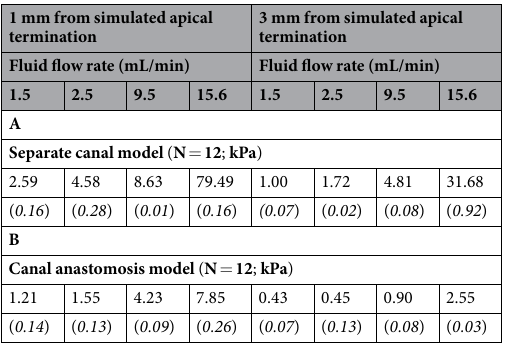
3 mm from simulated apical termination